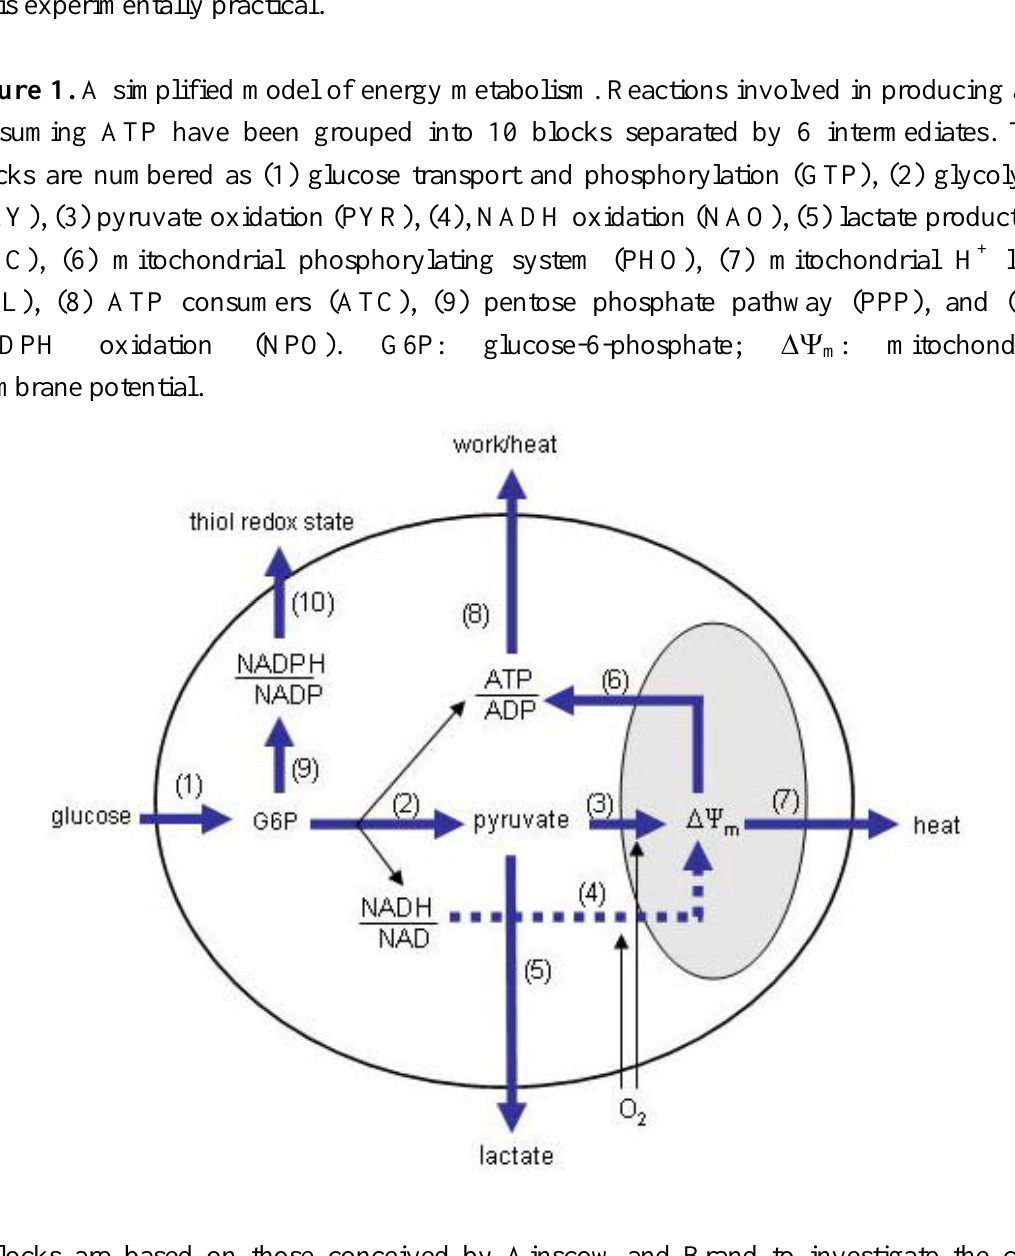
: mitochondrial m